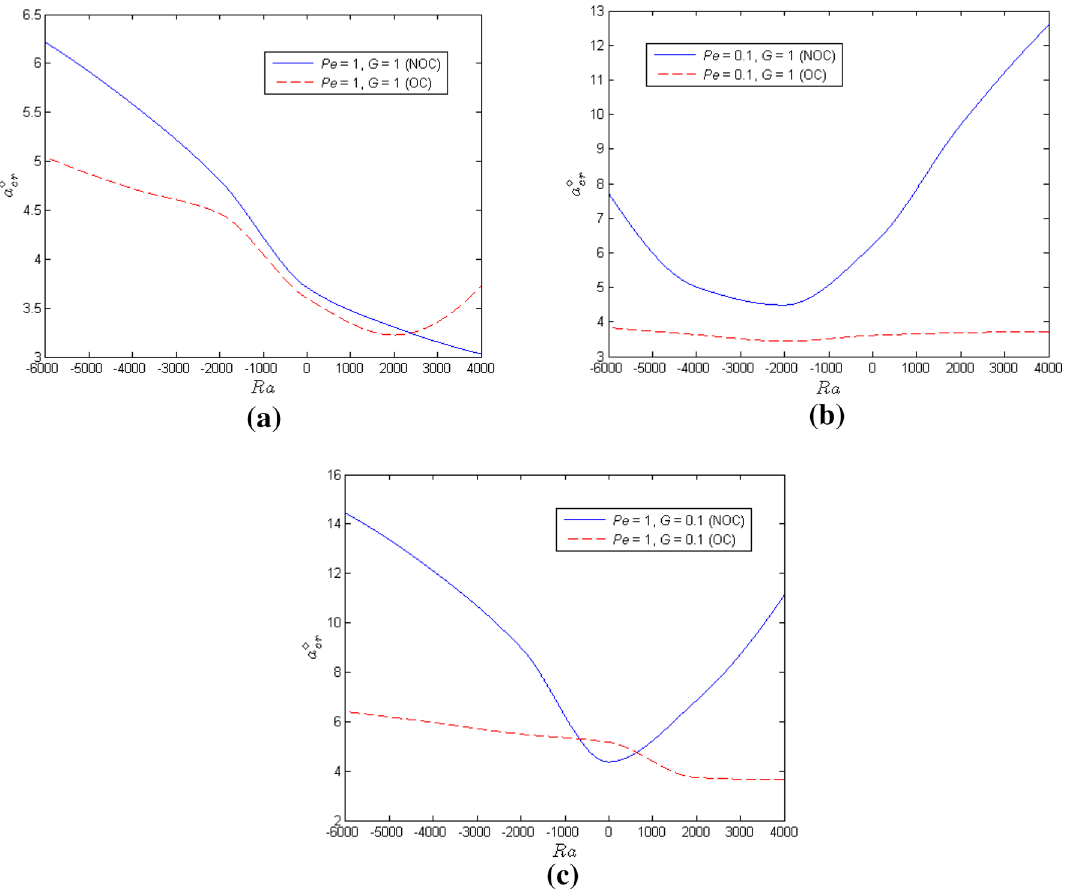
Fig. 4 The case of rigid lower and stress free upper walls: a – c Variation in thermal Rayleigh number verses critical wave number for the non– oscillatory and oscillatory modes of instability for the different values of gyrotactic number G and Péclet number Pe